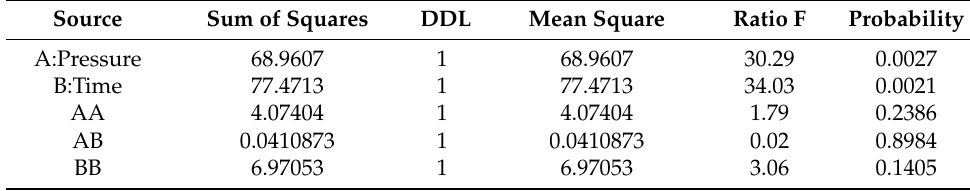
Table 4. Analysis of variance for apparent drying